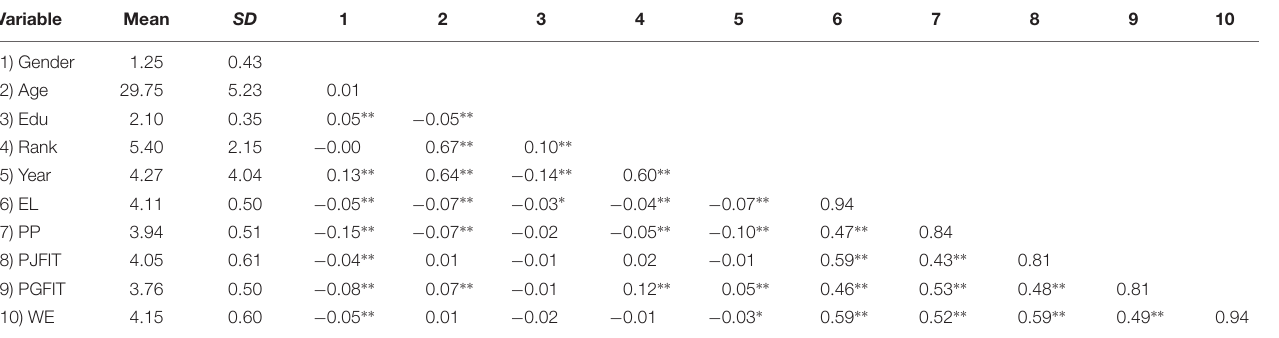
TABLE 1 | Means, standard deviations, and correlations for all included variables. Variable